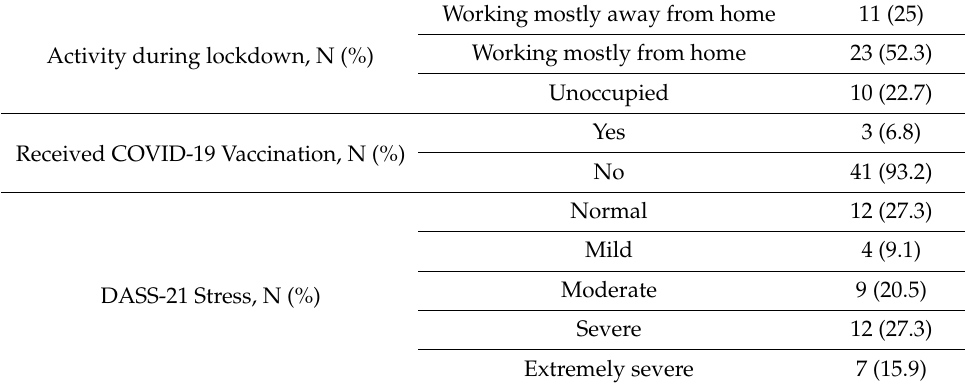
Table 2. Demographic features of our sample of individuals with HF-ASD.